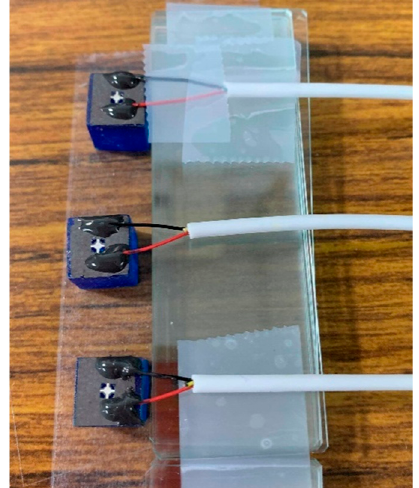
Figure 4. Complete PMUT device with the piezoelectric active film secured on the designed 3D printed base.